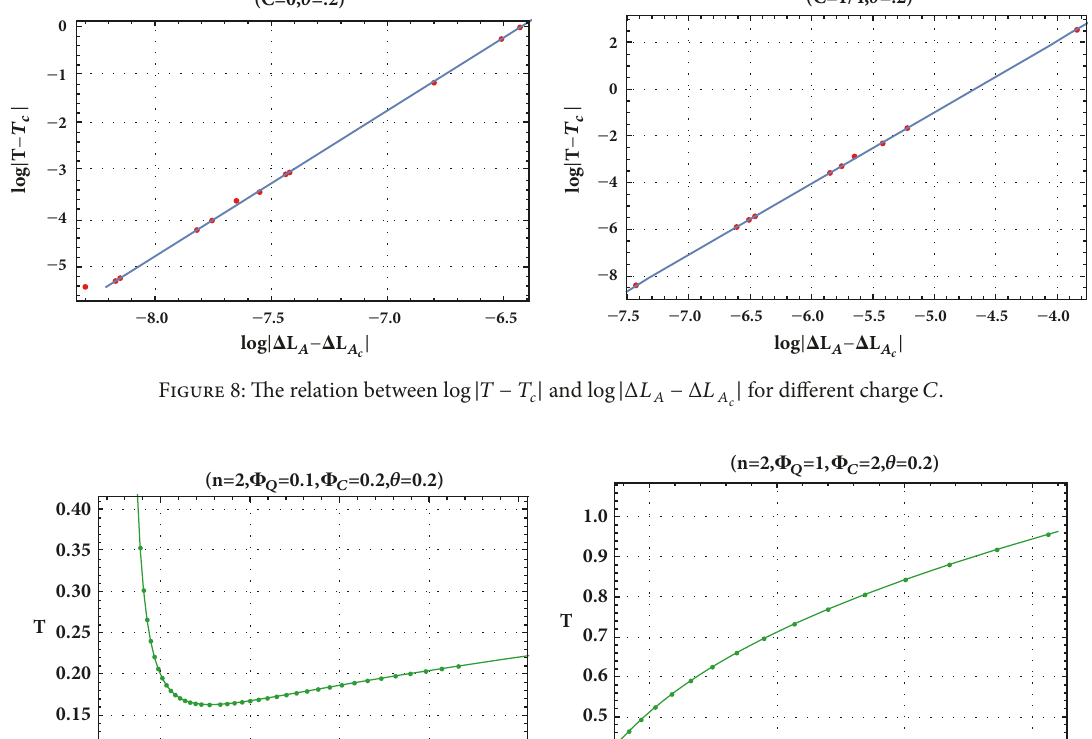
= 0.1, Φ = 0.2) . (Right) (Φ 𝑐 𝑄